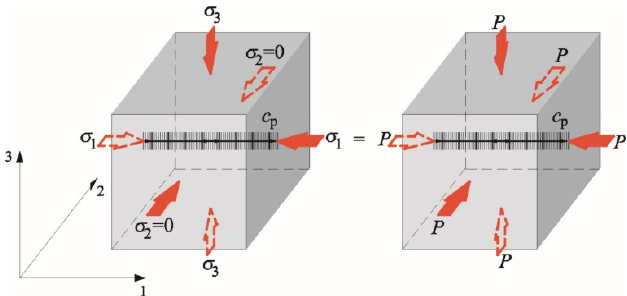
Figure 1. Directions of the stress and the ultrasonic wave in the isotropic material at the state of hydrostatic compression.